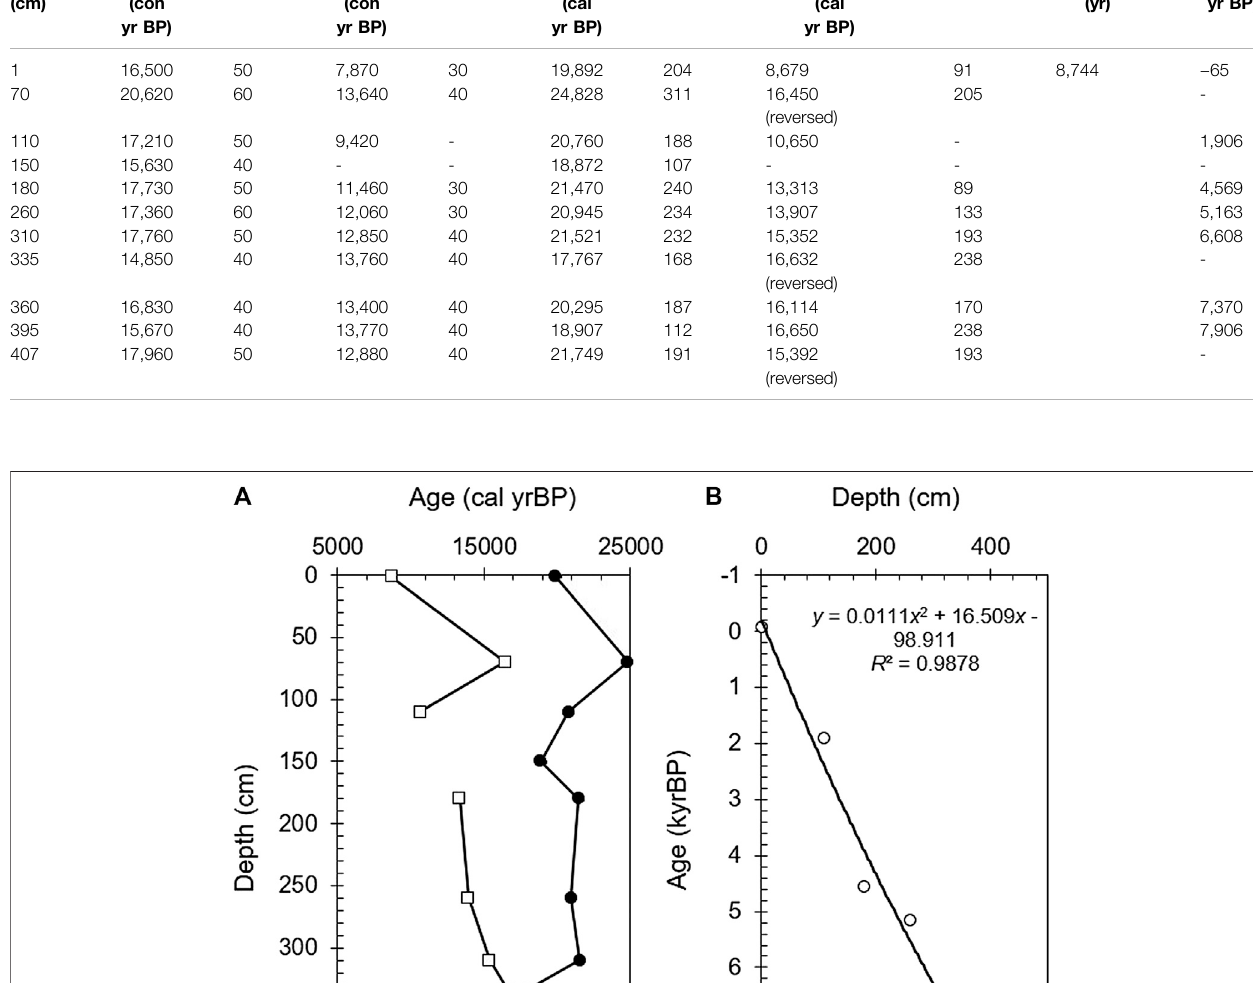
TABLE 2 | Conventional 14 C dating and calibration ages for core GZLC15-1 from Guozha Co Depth (cm)